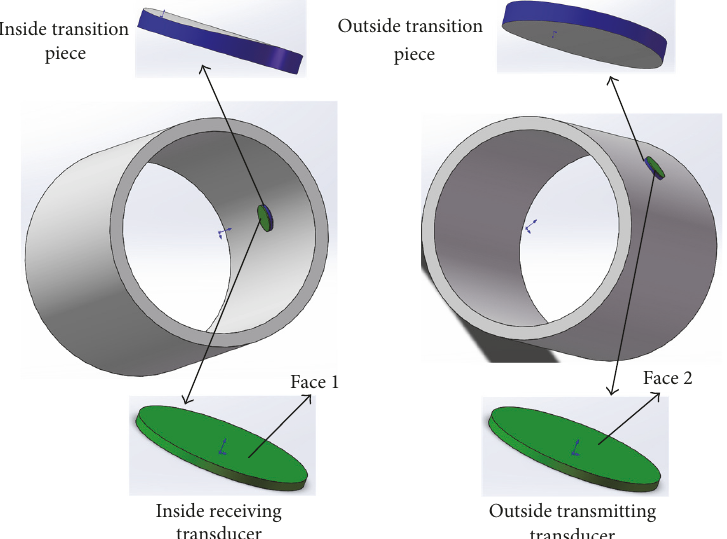
Figure 7: Three-dimensional geometric model of the wireless ultrasonic energy transmission channel through a cylindrical metal